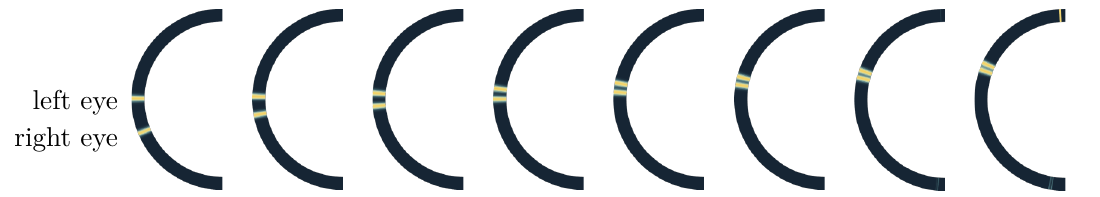
Figure 9 . A particle, initially fired at a right angle from the boundary at t = 0 , moves in the geometry of the BTZ black hole. Each slide shows the intensity detected by the active camera as a function of the return angle ϕ y . The shown times range over t = 0 . 5 . . . 4 in increments of 0 . 5 , with the temperature and other parameters as in (4.6). To add depth information, the images from two cameras displaced by ∆ y = 0 . 1 have been